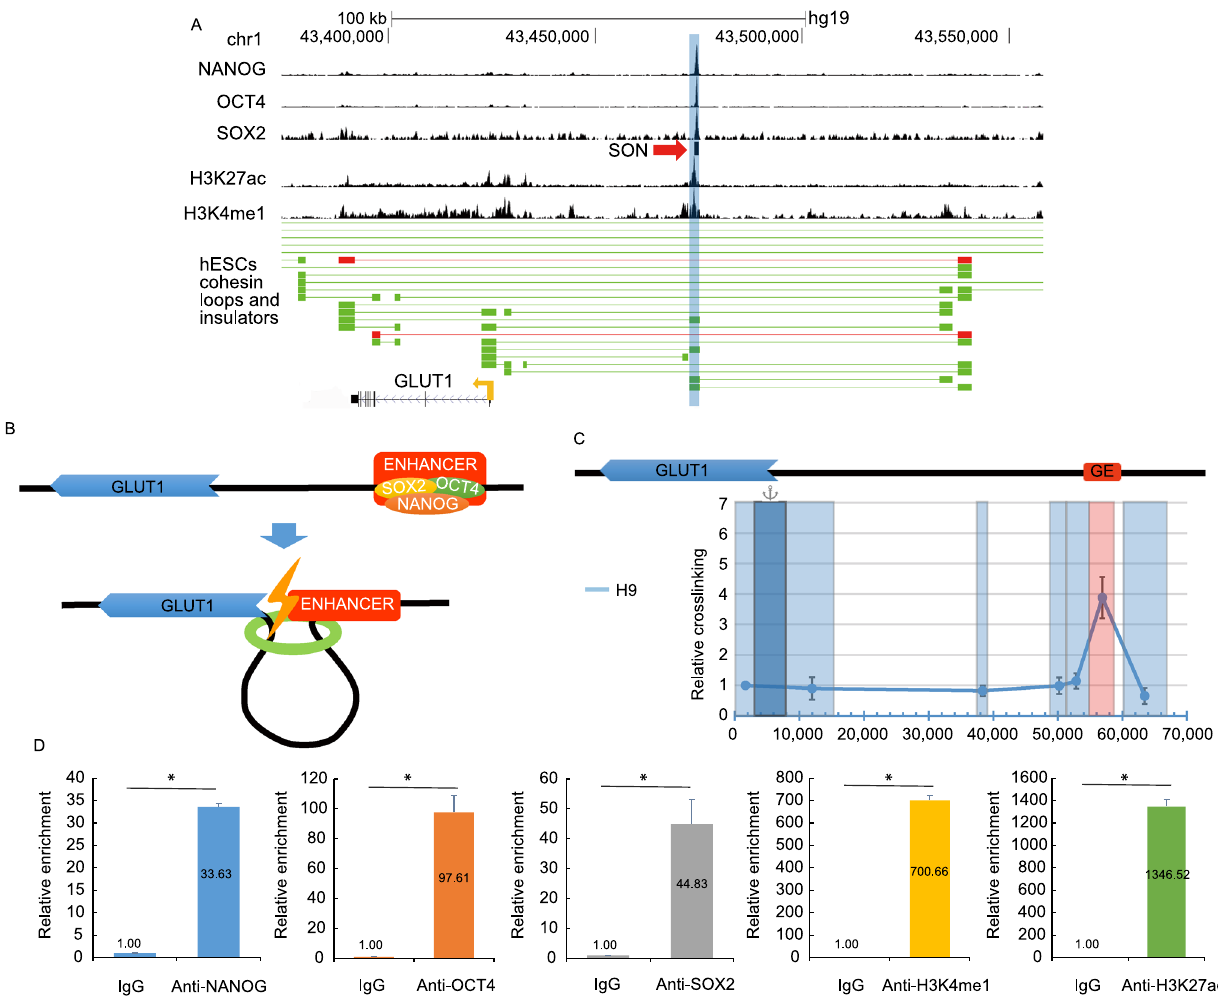
Figure 1. Identi fi cation of the GLUT1 enhancer, denoted GE, in hESCs. (A) Integrated analysis to predict the enhancer of GLUT1 in H9 hESCs. Based on the epigenetic signature of enhancers, the blue shaded region is the predicted enhancer of GLUT1 in hESCs. Insulator loop (red line) and cohesin loop (green line) involving the enhancer and promoter of GLUT1 are displayed, the blocks connected by a horizontal line show the interaction of two regions of the genome. Based on the ChIP-seq data, the binding sites for NANOG, OCT4, SOX2 as well as H3K27ac and H3K4me1 around GE are displayed at the top. The co-binding site of SOX2, OCT4 and NANOG (SON) is indicated with a red arrowhead. (B) A hypothetical model how the promoter and enhancer of the GLUT1 gene interact in hESCs. (C) 3C analysis con fi rmed the long-distance interaction between the promoter and enhancer of the GLUT1 gene. The GLUT1 promoter is indicated by dark blue and target restriction fragments light blue. GE-containing restriction fragment is shaded red. Primers were all forward orientation and positioned at the right end of each restriction fragment. Relative cross-linking value for each restriction fragment was plotted over the 70 kb genomic DNA fragment. Data represent mean ± SEM. n = 3. The value of the crosslinking between promoter and the nearest neighboring fragment is arbitrarily set to 1. (D) ChIP-qPCR assay was used to con fi rm the binding of SON to GE and the epigenetic signature of GE in hESCs. Data represent mean + SEM. n =